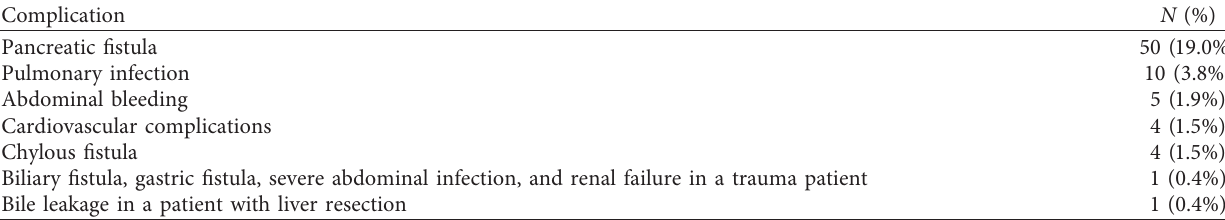
Table 3: Postoperative